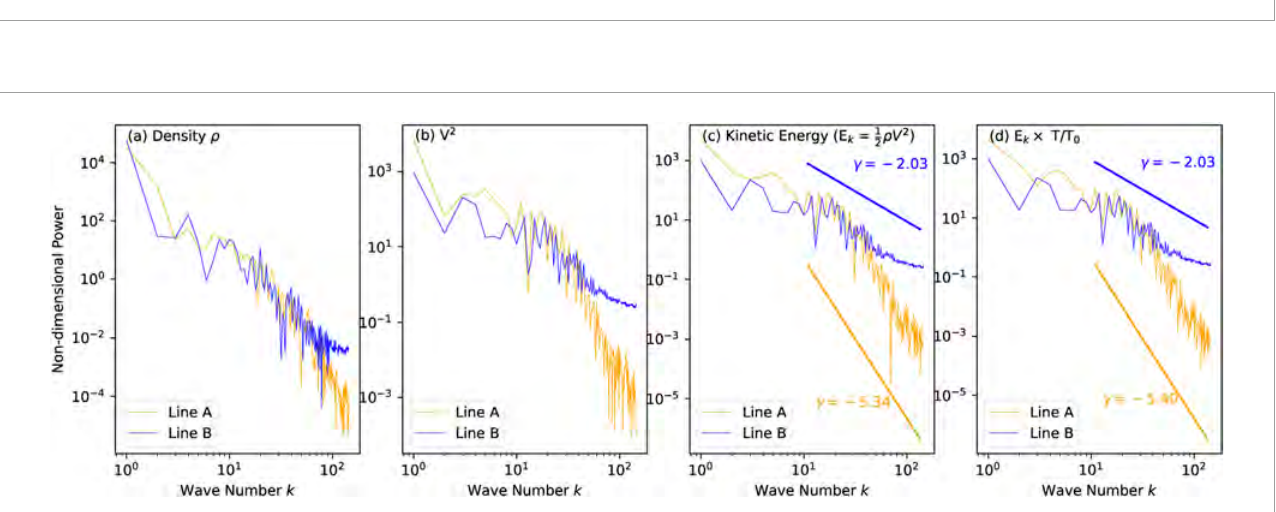
FIGURE 7 Fourier power spectrum along the sampling lines A and B for (A) density perturbations, (B) velocity power, (C) kinetic energy perturbations, and (D) temperature-weighted kinetic energy. The peak formation temperature T 0 for Fe XXI lines is about 11.5 MK in panel (D) . The horizontal axis is wave numbers, and the vertical axis is non-dimensional power. The γ indicates the power index by fitting the spectrum profiles with power-law functions ( ∼ k − γ ) .